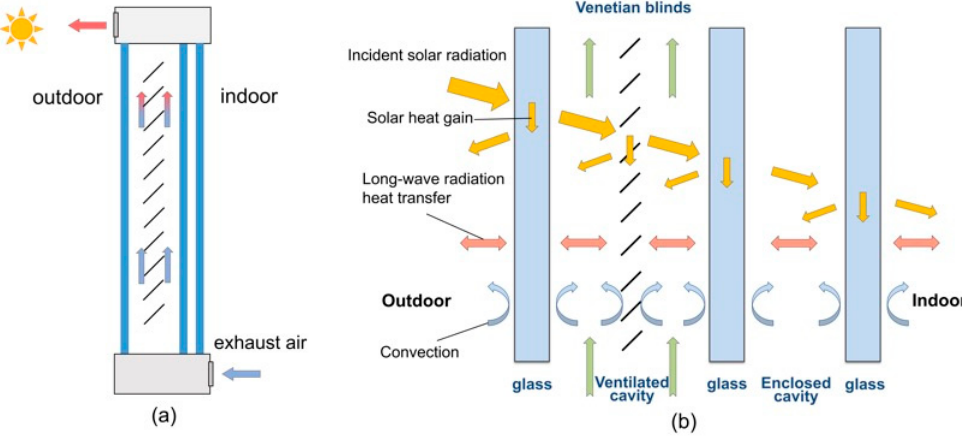
Figure 1. Schematic and principle of the EAGU: ( a ) configuration; ( b ) heat transfer process.